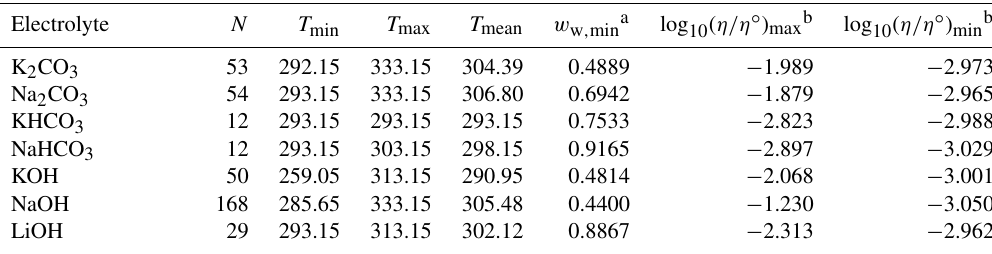
Table 3. Data set information for bulk measurements of binary aqueous electrolyte solutions used to fit the AIOMFAC-VISC electrolyte model. All data have been aggregated by Laliberté (2007,